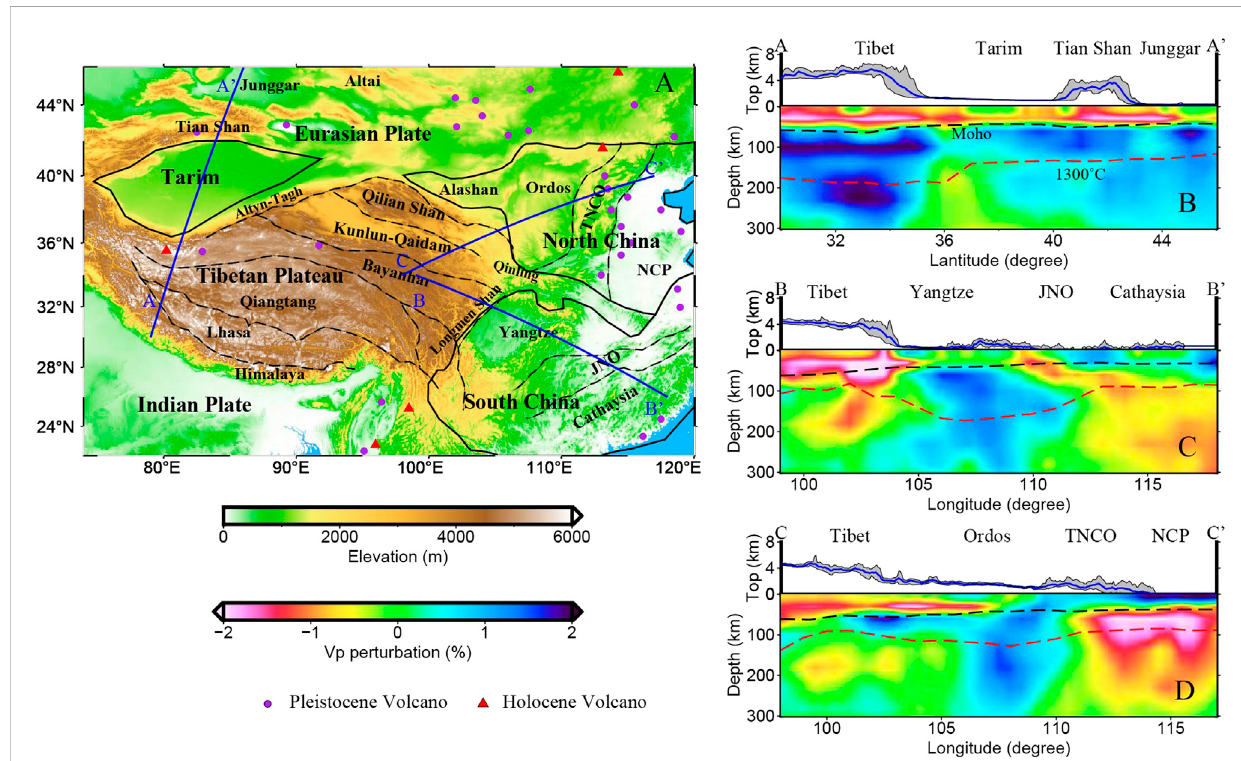
FIGURE 1 TectonicbackgroundfortheTibetanPlateauandsurroundingregions (A) ,andlithosphericstructureacrosstheTarim (B) ,SouthChinablock (C) ,and NorthChinacraton (D) basedonthePwavetomography(Weietal.,2012).RedtrianglesandpurpledotsindicatetheHoloceneandPleistocenevolcanos, respectively (https://volcano.si.edu/volcanolist_pleistocene.cfm). Dashed lines in (A) indicate the block boundaries. Gray areas in (B – D) indicate the topographicchangealongthethreepro fi les.Theswathwidthofeachpro fi leis40 km.Blackdashedlines (B – D) indicatetheMohosurfacebasedon theCrust1.0model(Datafromhttps://igppweb.ucsd.edu/~gabi/crust1.html).Reddashedlines (B – D) indicatethebaseofthethermallithosphere(Anand Shi, 2006). JNO: Jiangnan orogen; TNCO: Trans-North China orogen; NCP: North China